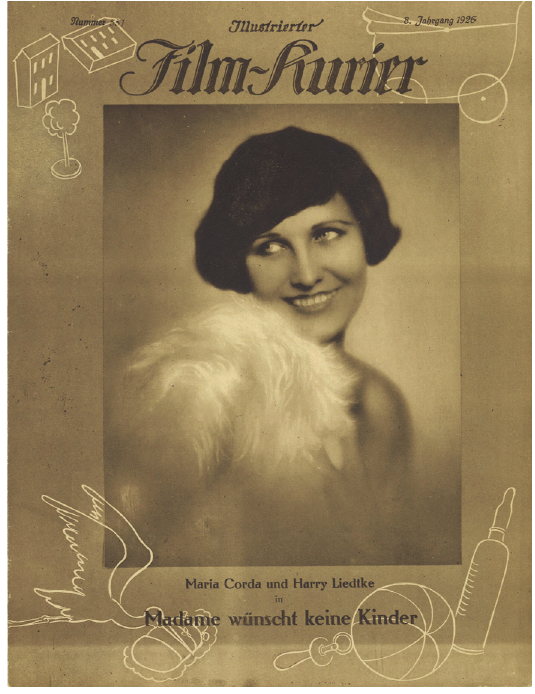
Figure 11. Cover of a film-program to be sold in cinemas showing ‘Madame doesn’t want children’, 1926. © Christian